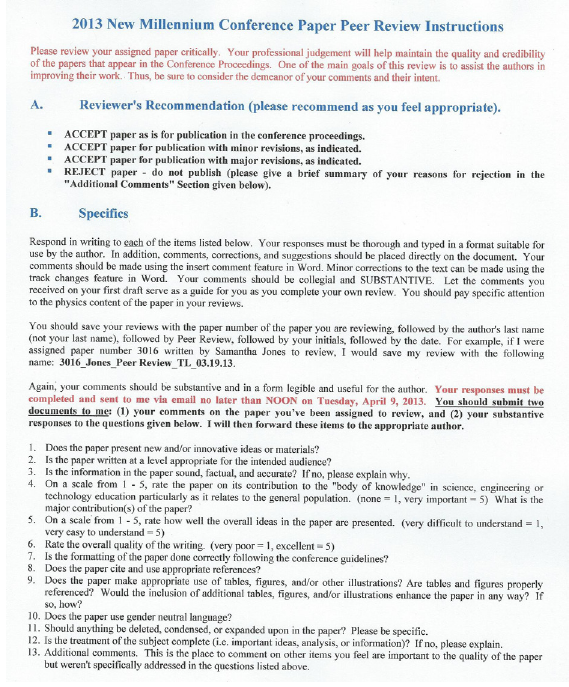
Figure 7. The peer review